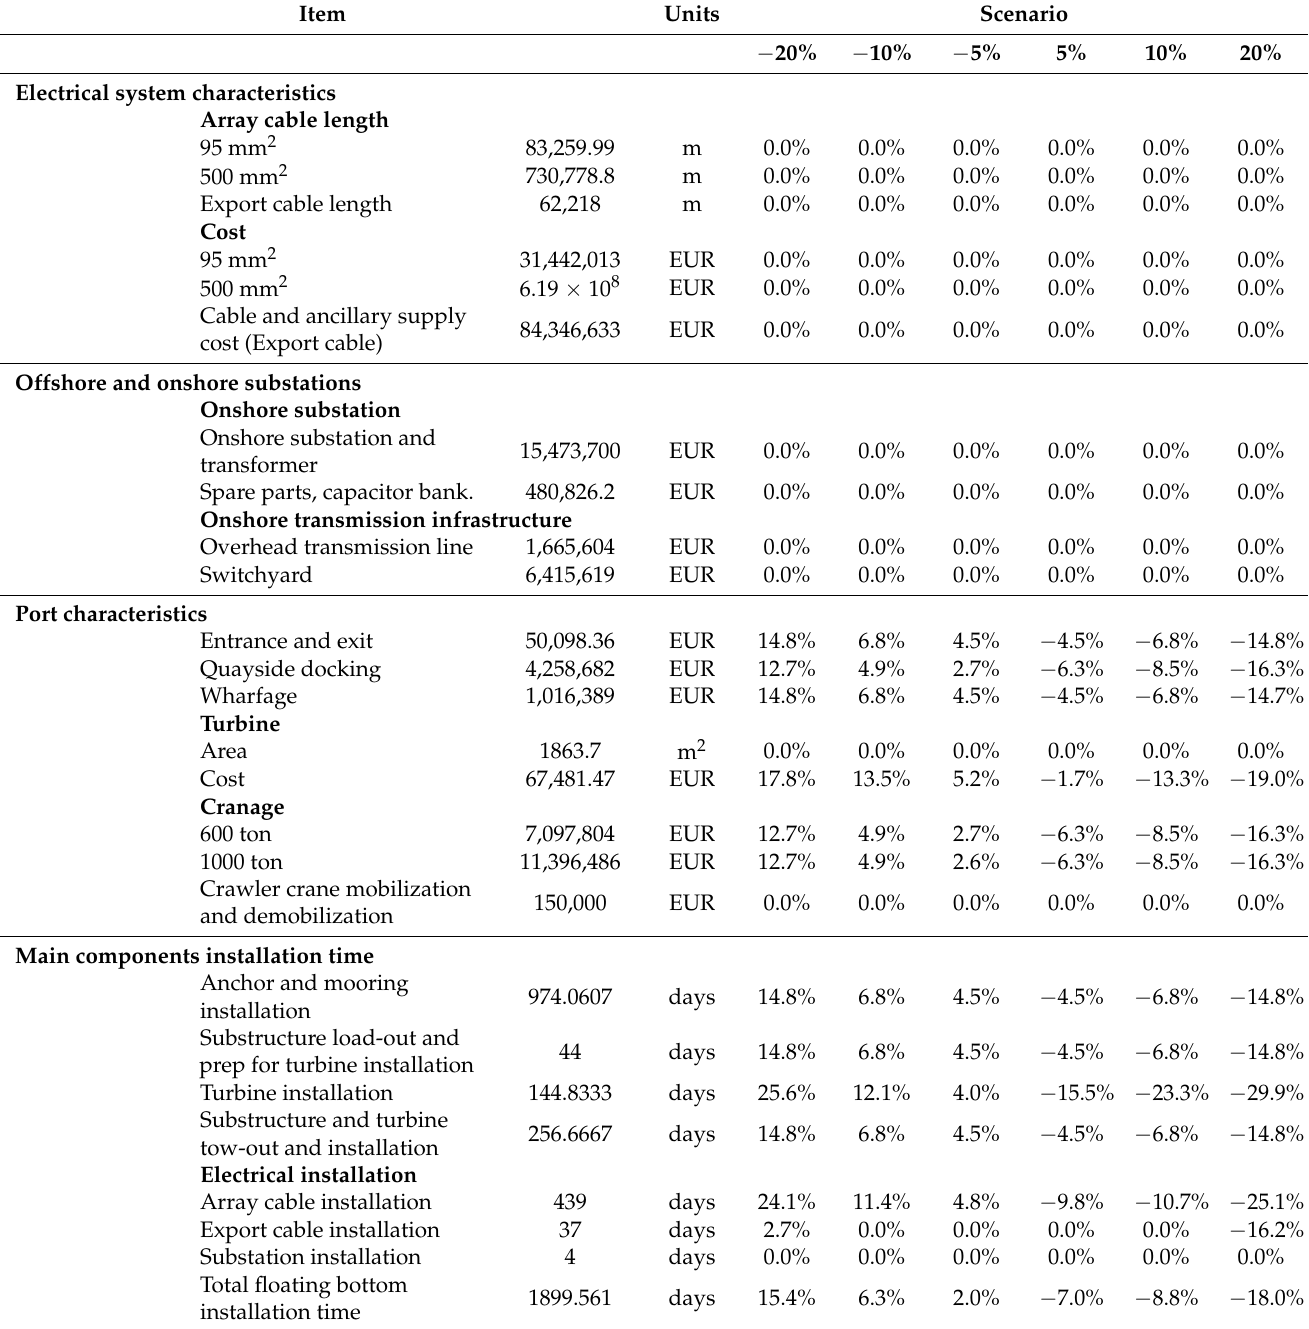
Table A5. Variability associated with the initial work schedule of 320 days (as a function of weather